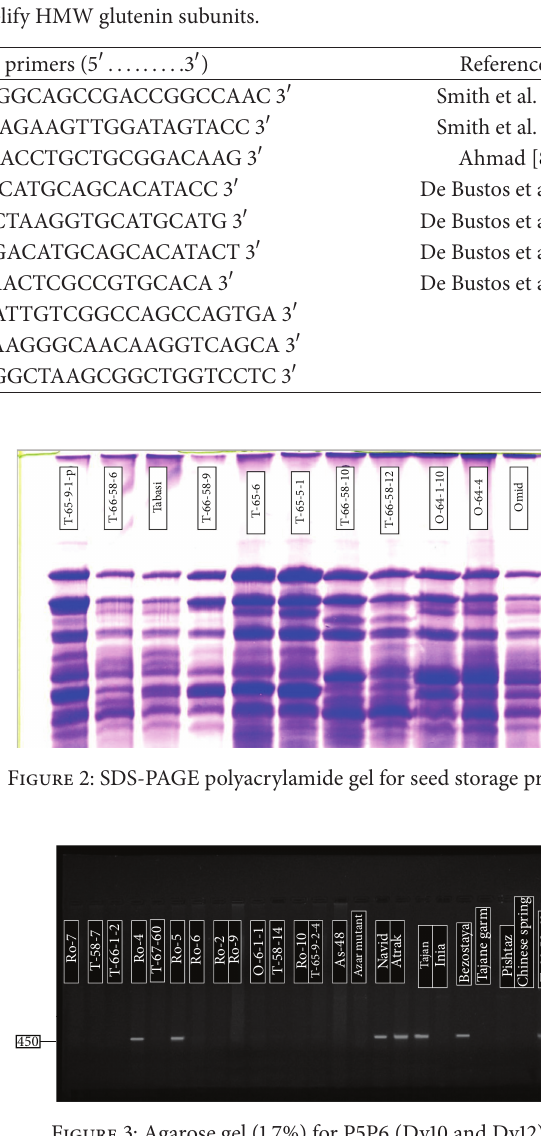
Figure 3: Agarose gel (1.7%) for P5P6 (Dy10 and Dy12).